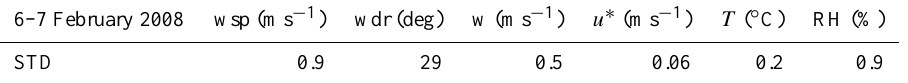
Table 2. Anemometer mean standard deviations for 6–7 February 2008; wsp indicates horizontal wind speed, wdr is the horizontal wind direction, w is the vertical wind velocity, u ∗ is the friction velocity, T is the temperature, RH is the relative humidity.